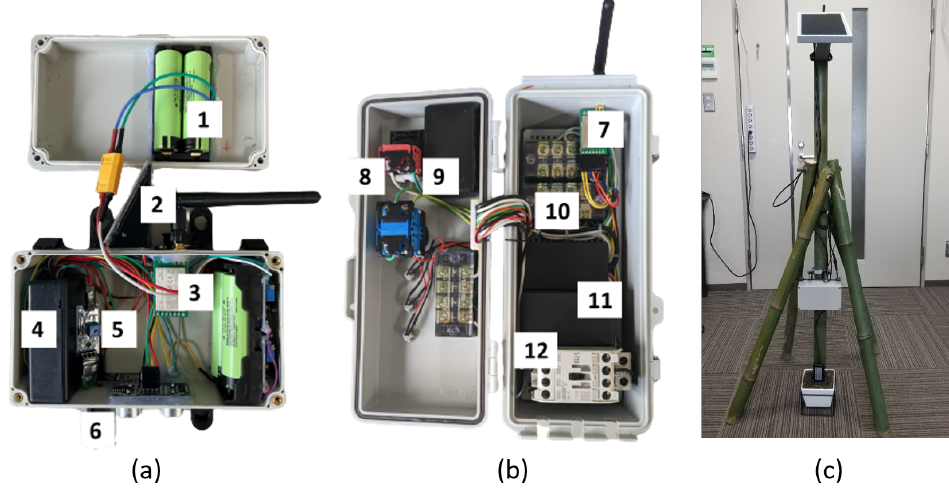
Figure 15. The monitoring and control subsystems of our smart agriculture use-case. ( a ) The monitoring subsystem consists of: (1) 18650 lithium–ion battery pack, (2) LM393 Rain Sensor, (3) E32-900T20D LoRa radio module, (4) Arduino nano hlATmega328P microcontroller in a protective enclosure, (5) SHT20 I2C temperature and humidity sensor, (6) HC-SR04 ultrasonic sensor. ( b ) The control subsystem, consisting of: (7) E32-900T20D LoRa radio module, (8) emergency push button and two-pole switch, (9) power supply for 5V components, (10) connection terminals, (11) Arduino nano ATmega328P microcontroller, 5 V relay and ACS712 current sensors in a protective enclosure, (12) Mitsubishi Electric S-T10 three-pole contactor. ( c ) Test deployment of the monitoring